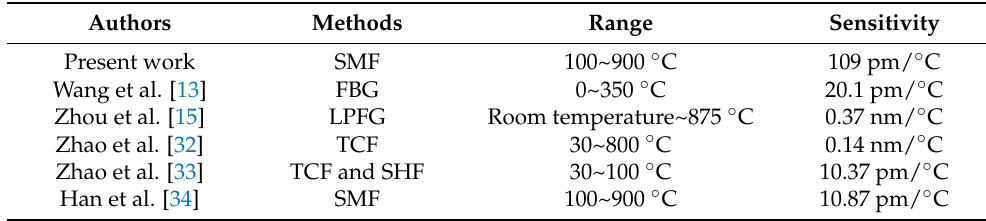
Table 2. Comparison of the fiber temperature sensors.